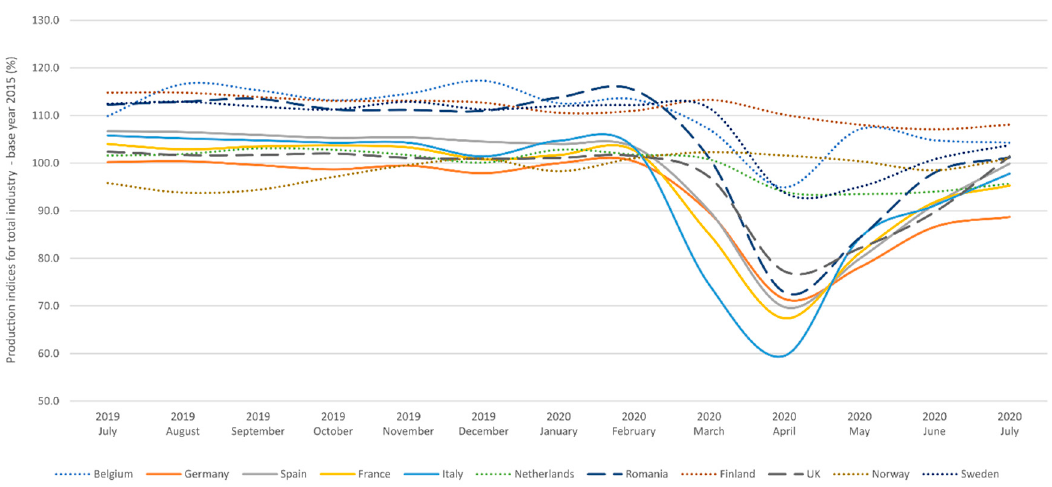
Figure 13. Industrial Production Index (base year 2015) for the July 2019–July 2020 period (data source: Eurostat, 2020).